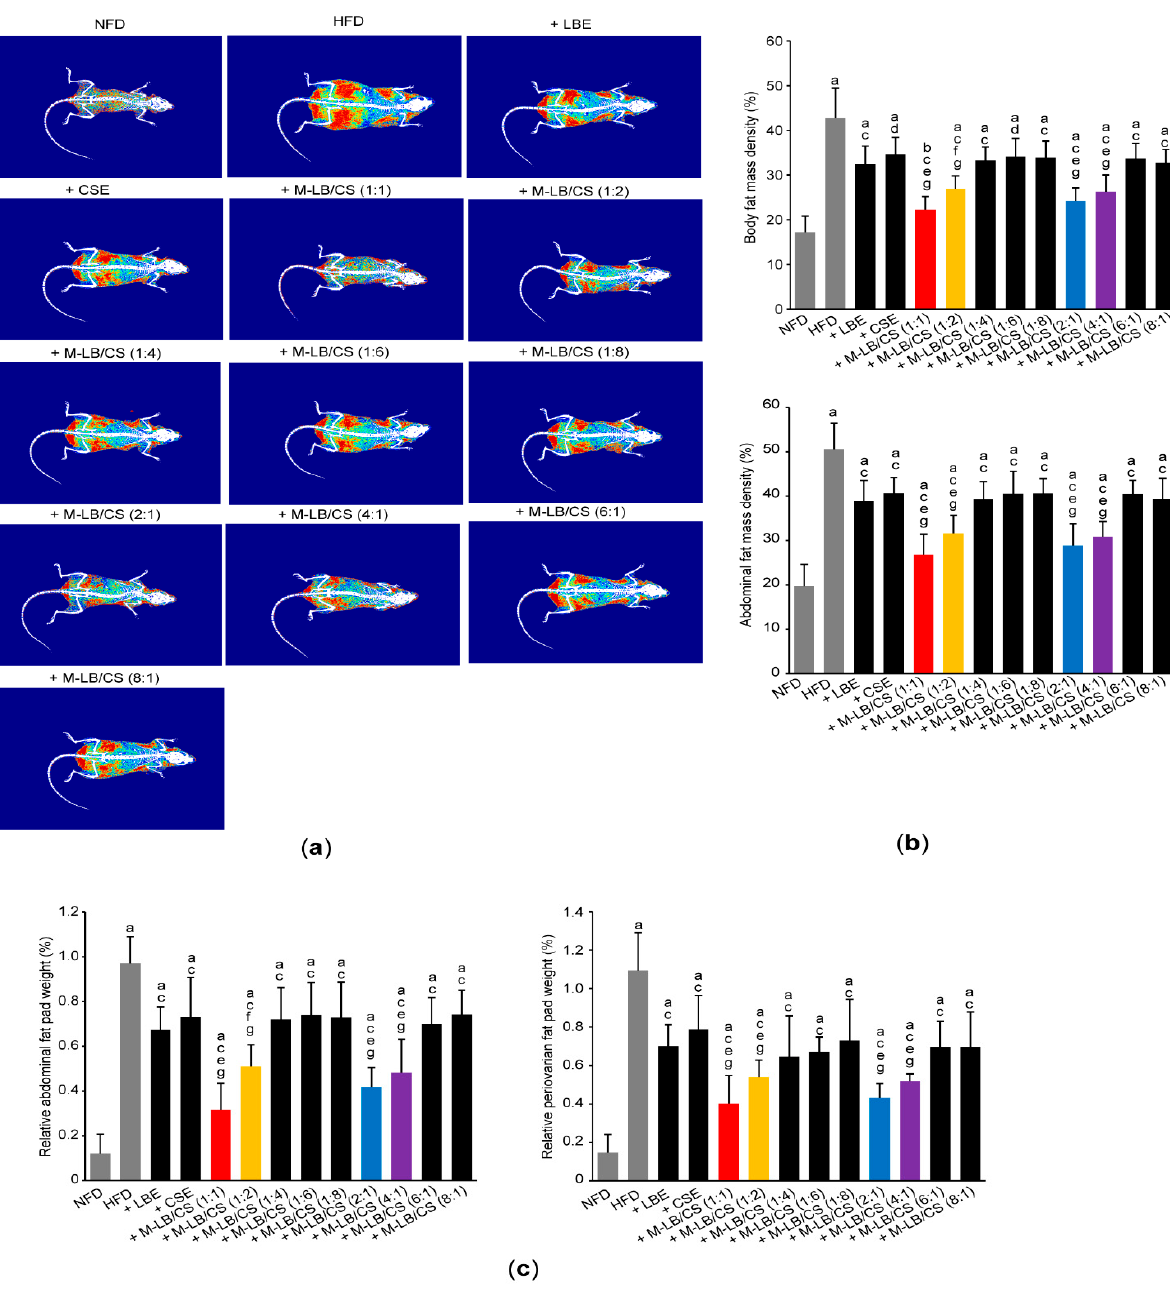
Figure 3. M-LB/CS decreases fat deposition in mice fed an HFD. ( a ) Representative DEXA images of experimental groups. ( b ) Fat mass densities of whole body ( upper ) and abdominal region ( lower ) were calculated from DEXA. ( c ) Abdominal ( left ) and periovarian ( right ) fat pad weights were normalized by body weight. a p < 0.01, b p < 0.05, vs. NFD; c p < 0.01, d p < 0.05, vs. HFD; e p < 0.01, f p < 0.05, vs. HFD + LBE; g p < 0.01, vs. HFD + CSE; DEXA—dual-energy X-ray